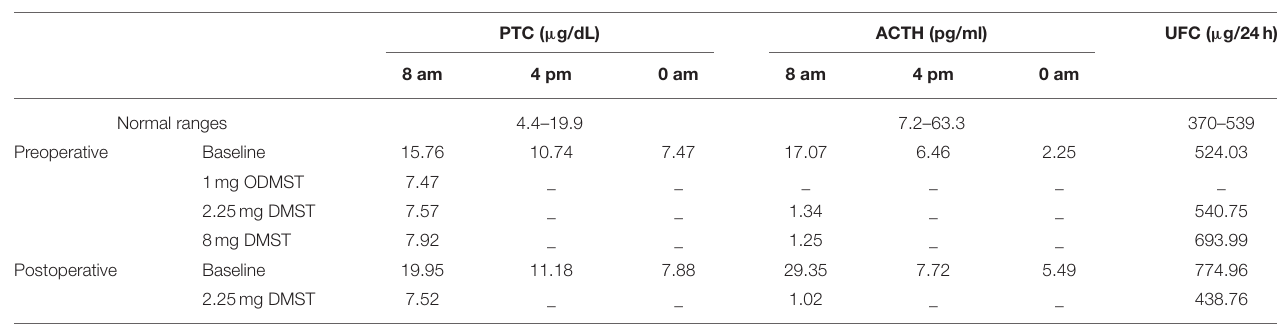
TABLE 2 | Cortisol circadian and dexamethasone suppression tests.